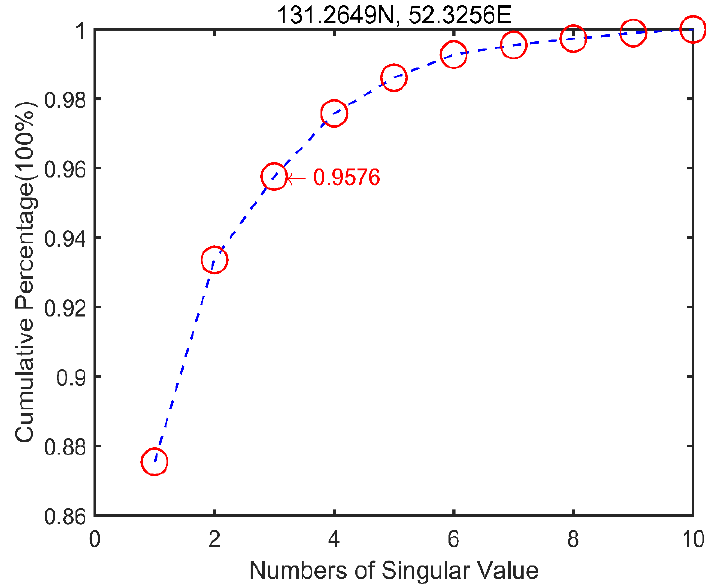
Figure 4. The typical example of cumulative percentage of singular value.